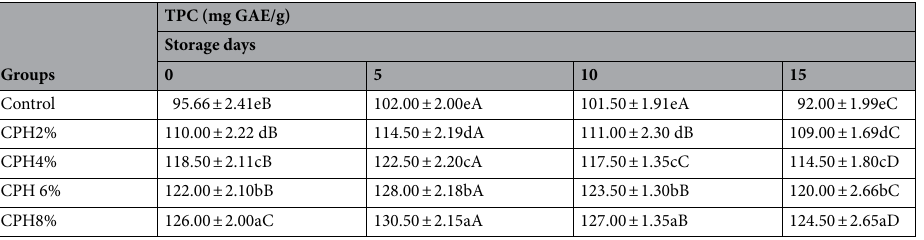
Table 1. Total phenolic content of casein protein hydrolysate (CPH) incorporated beef nuggets during storage. CPH: casein protein hydrolysate. All the values are means of triplicate determinations ± Standard Deviation (SD). Means within the column with different small letters are significantly different (p < 0.05) and different capital letters within the row differed